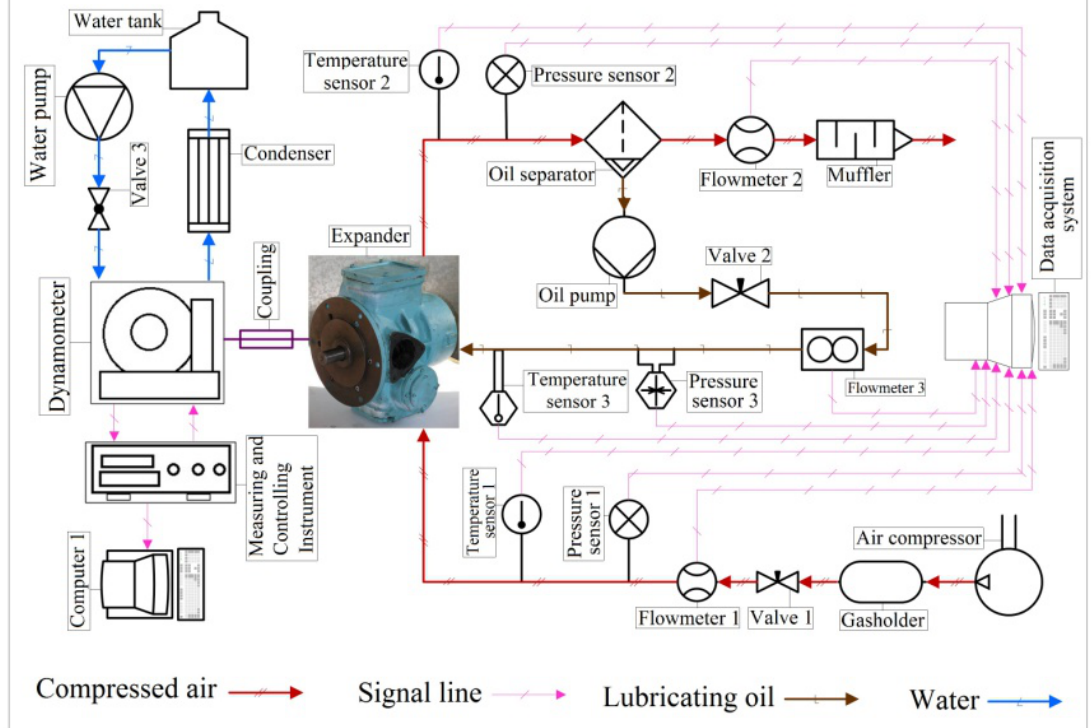
Figure 4. Schematic diagram of the screw expander experimental